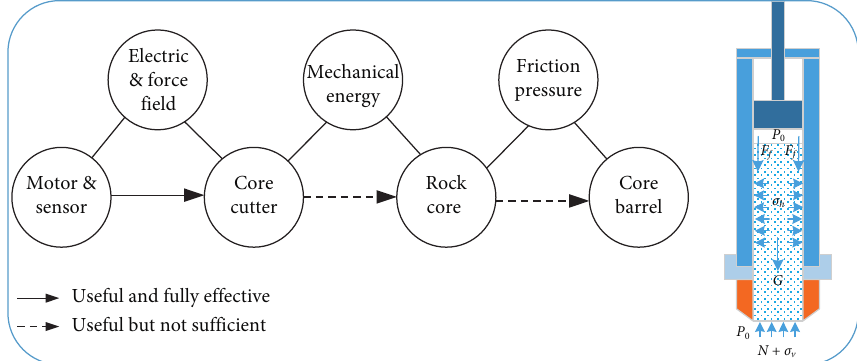
Figure 6: Substance-field model of the hard-rock sampler drilling.